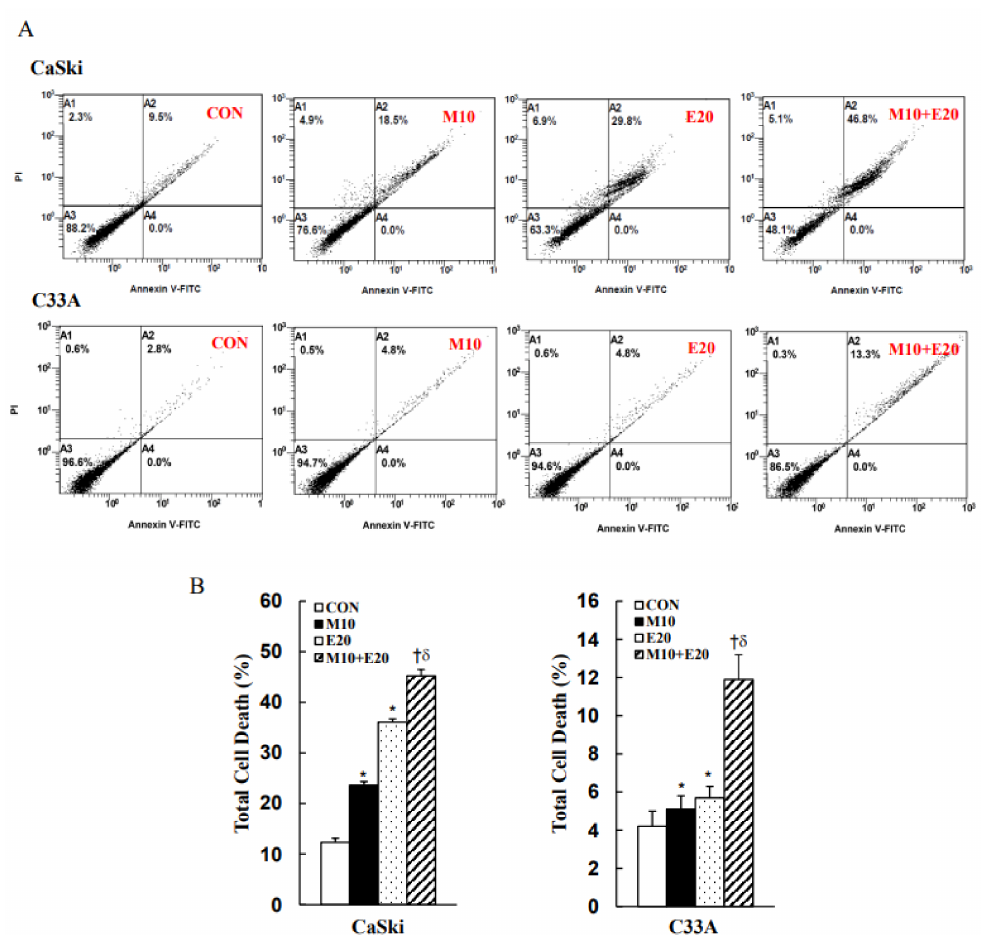
Figure 2. Metformin and everolimus induced apoptosis in cervical cancer cells. CaSki and C33A cells were treated with metformin (10 mM) with or without everolimus (20 µ M) for 48 h. ( A ) Apoptosis profile assessed using an Annexin V/PI assay by flow cytometry. ( B ) Quantitative results of apoptotic cells (Annexin V- and PI-stained cells) presented in the bottom plot. Values represent the mean ± SD from three replicates. *, † and δ p < 0.05 compared with CON, Met 10- or Eve 20-treated groups. CON, 0.1% DMSO; M10, 10 mM metformin; E20, 20 µ M